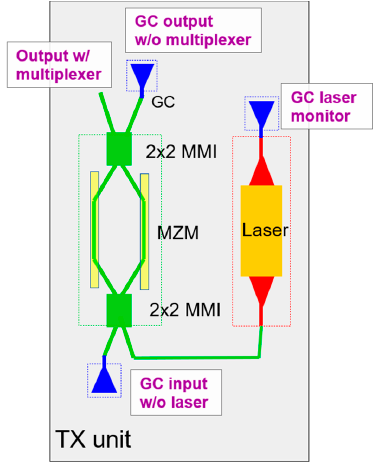
Figure 5. Transmitter cell layout for WDM and CWDM. The cell footprint is 1000 μ m × 1750 μ m. GC—Grating Coupler, MZM—Mach–Zehnder Modulator, MMI—Multimode Interference Coupler, w—with, w/o—without. The cell output with multiplexer from 4 cells is waveguided to an echelle grating multiplexer.